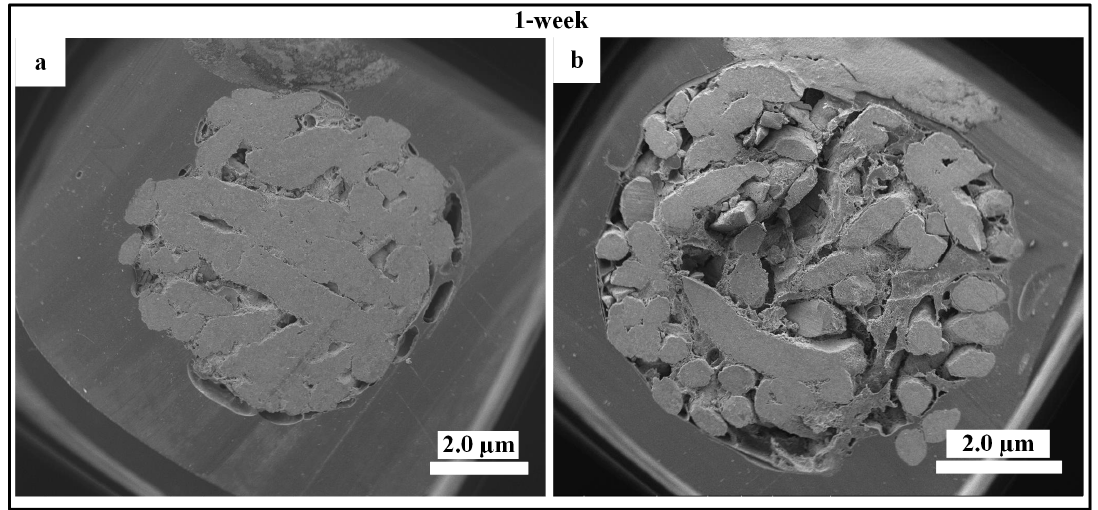
Figure 9. SEM high-magnification pictures characterized HA and Cu 5 -HA after one week of implantation: ( a) no blood vessels formed on HA scaffolds and ( b ) blood vessels formed on Cu 5 -HA.